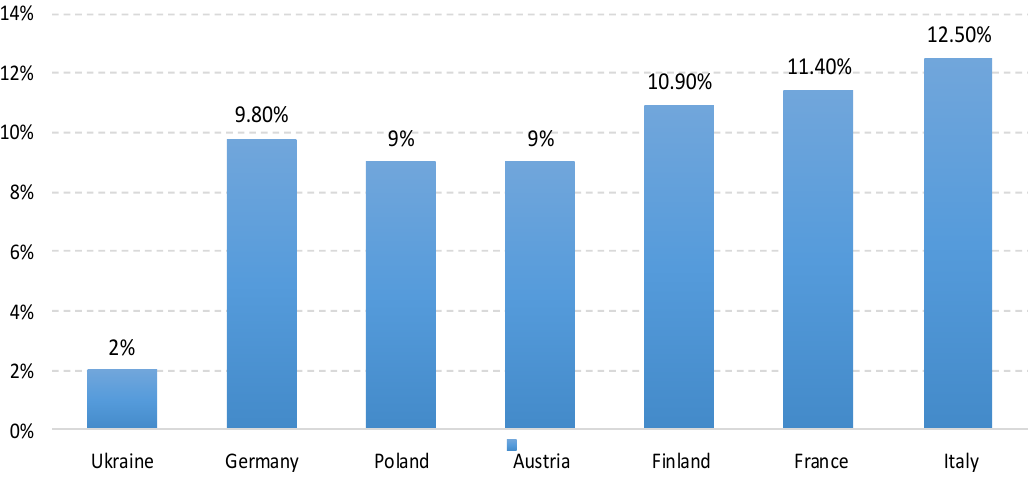
Figure 2. Property share percentage of GDP in European